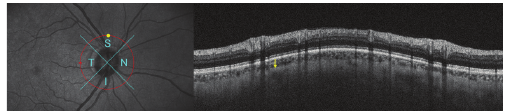
Figure 2: Measurement of peripapillary choroidal thickness patient with PEX glaucoma. Yellow arrow indicates the choroidal thickness in the superior